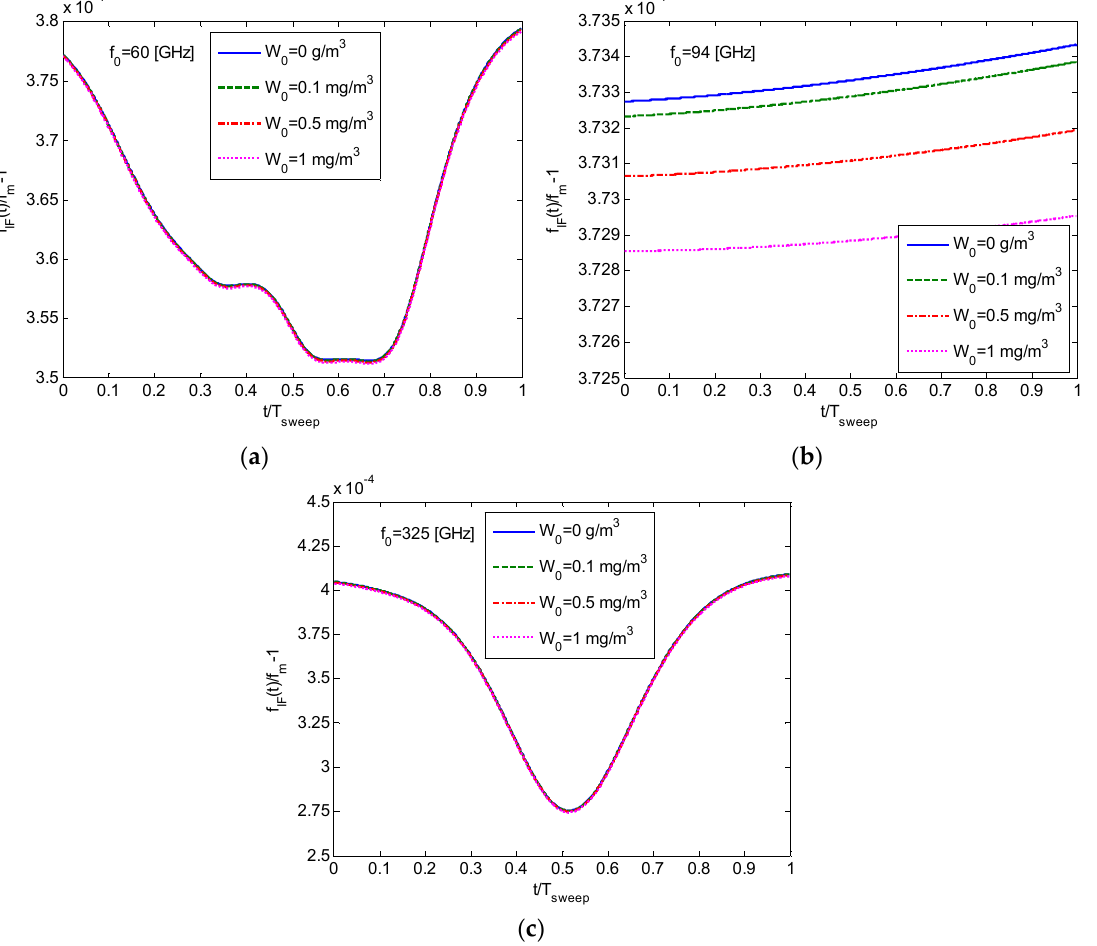
f t f  obtained for different frequencies Figure 3. Variation of the instantaneous frequency   / 1 IF m Figure 3. Variation of the instantaneous frequency f IF p t q{ f m ´ 1 obtained for different frequencies and fog conditions. ( a ) 60 GHz; ( b ) 94 GHz; ( c ) 325 GHz. and fog conditions. ( a ) 60 GHz; ( b ) 94 GHz; ( c ) 325